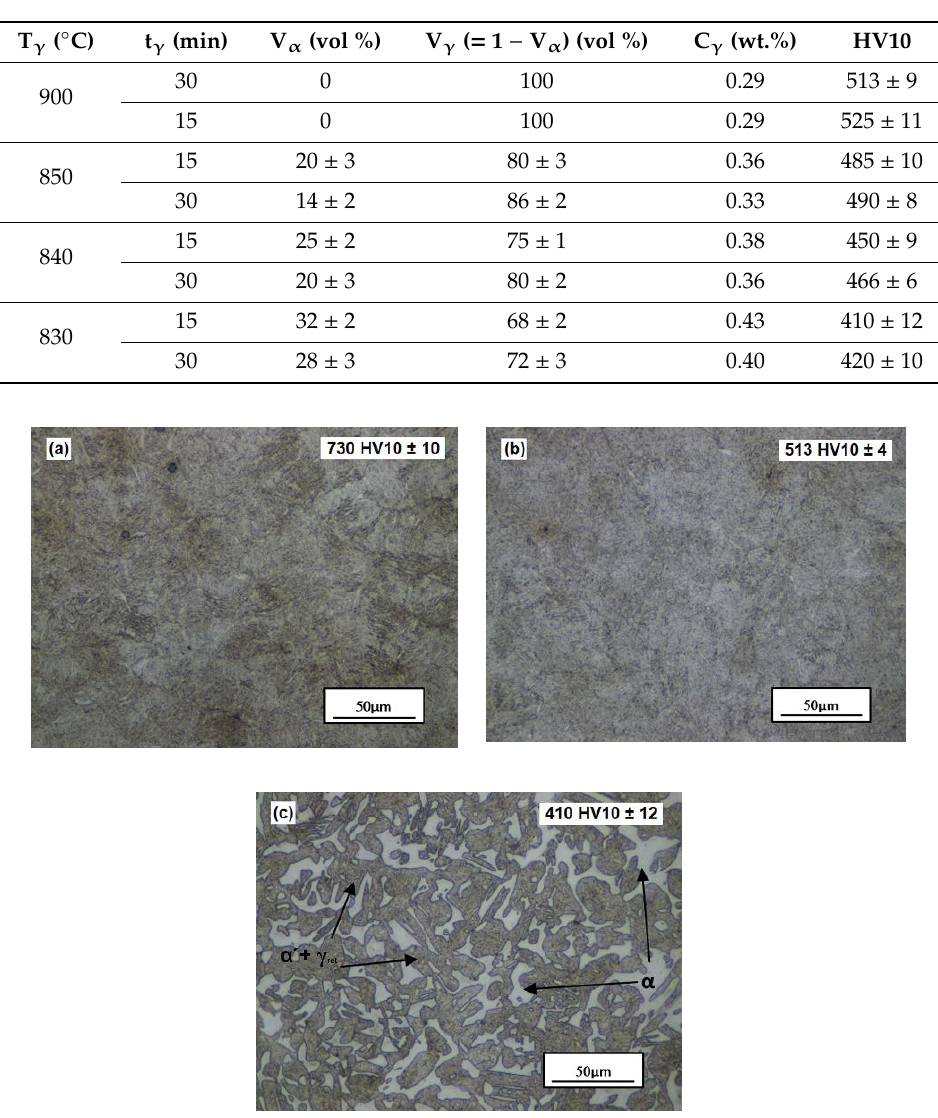
Figure 2. Light optical micrographs of austenitized and quenched samples: ( a ) 0.76 wt.% C alloy after austenitized at 900 ◦ C / 30 min and for the 0.29 wt.% C ( b ) austenitized at 900 ◦ C / 30 min, ( c ) austenitized at 830 ◦ C / 15 min. Etched with Picral. Table 3. For the 0.29 wt.% C alloy, metallographic measurements of proeutectoid ferrite (α) fraction V α . V γ stands for the amount of austenite at the mentioned T γ -t γ conditions. C γ is the estimated carbon content in the austenite calculated as described in the main text. HV10 is at hardness Vickers load 10 kg.